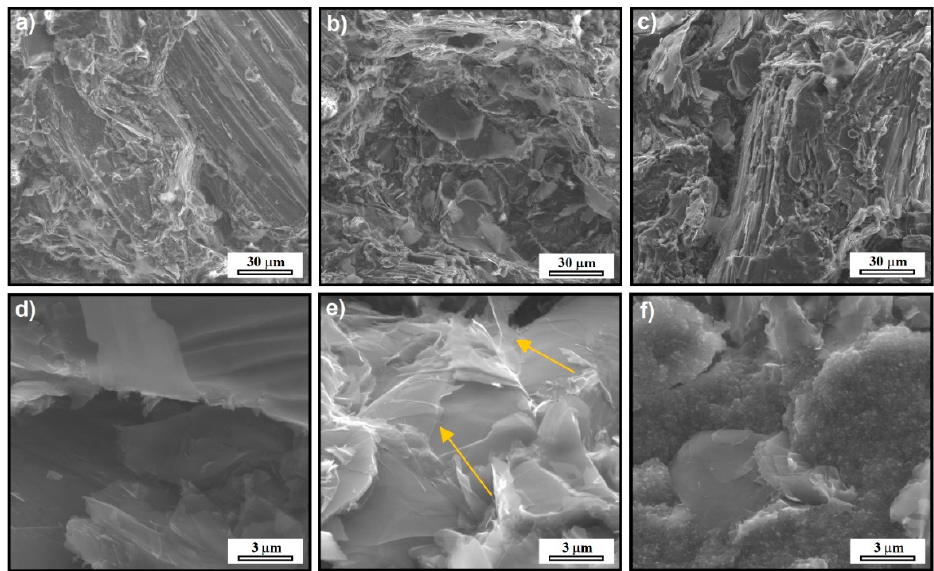
Figure 3. SEM images of EP/SG composite without nanofillers ( a , d ); with graphene nanoplatelets ( b , e ); with carbon black ( c , f ).